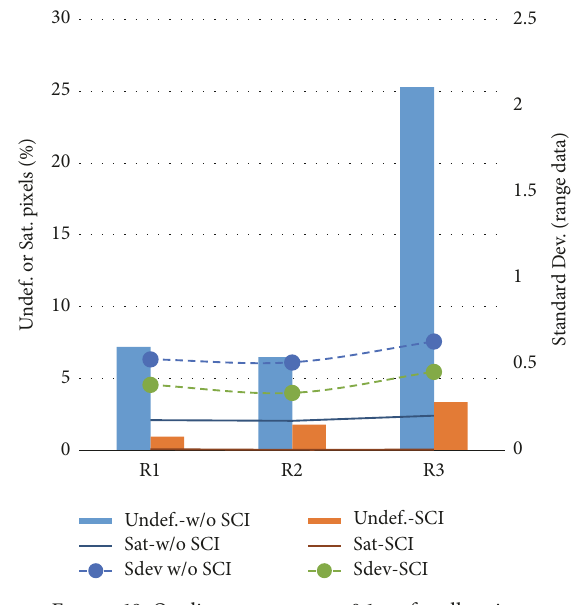
Figure 18: Quality parameters at 0.1 ms for all regions.